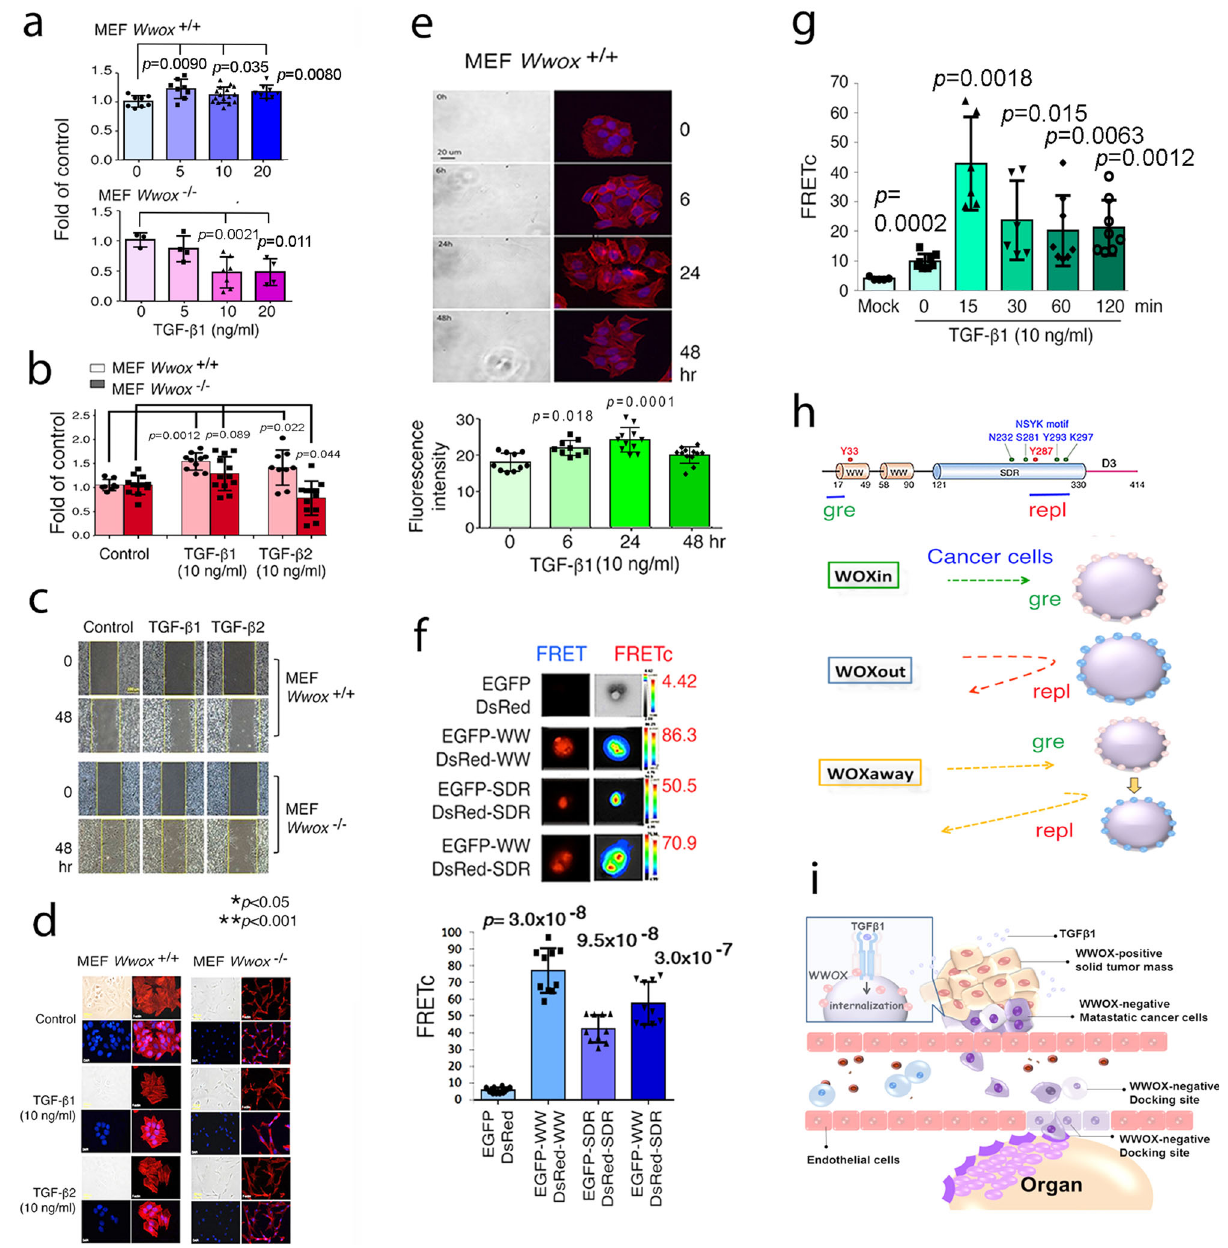
Fig. 10 TGF- β 1-enhancement of the migration of wild type MEF cell migration is associated with stress fi ber formation and modulates WWOX self- binding or intermolecular association. a Wwox + / + and Wwox -/- MEF cells were treated with TGF- β 1 for 48 hrs. The extent of cell migration was measured. TGF- β 1 promoted wild type cell migration and suppressed the knockout cell migration in a dose-dependent manner. b , c Under similar conditions, TGF- β 1 and TGF- β 2 promoted the wild type cell migration. TGF- β 2 suppressed knockout cell migration. d MEF cells were treated with TGF- β 1 or TGF- β 2 for 48 h. In wild type cells, TGF- β 1/- β 2 induced stress fi ber formation as the F-actin appeared as bundles in cytoplasm. However, in the knockout cells, the arrangement of F-actin showed no apparent differences between control and TGF- β stimulated cells. e In wild type MEF cells, TGF- β 1 stimulated stress fi bers formation in a time-dependent manner. F-actin (red) was stained by phalloidin. DAPI (blue) stain reveals the nuclei (mean ± s.d., n = 10, student ’ s t test). f COS7 fi broblasts were co-transfected with a pair of expression constructs: (1) EGFP and DsRed, (2) EGFP-WW ( N -terminal 1st and 2nd WW domains) and DsRed-WW; (3) EGFP-SDR and DsRed-SDR; (4) EGFP-WW and DsRed-SDR. FRET analysis was carried out. The extent of speci fi c protein/protein interactions is calculated as FRETc. g TGF- β 1 (10 ng/ml) increased the binding between WW and SDR domain in 15 min, followed by gradual decrease with time (mean ± standard deviation; n = 30; Student ’ s t test). h The potential modes of cell migration are: (1) WOXin: WWOXd cells look for WWOXd or gre-exposed WWOXf cells in the lymphatic capillaries or organs for docking and invasion; (2) WOXout: WWOXd cells turn away from repl-exposed WWOXf cells; (3) WOXaway: WWOXd cells physically contact and merge with gre-expressing cells, but walk away upon gre turning to repl. i Cancer cell-derived TGF- β 1 induces internalization of WWOX and T β RII that facilitate the cell migration. WWOXf parental cells in the solid tumor can no longer recognize the WWOXd cells and repel them to depart. These metastatic cells look for WWOXd or gre-exposed WWOXf cells in the blood or lymphatic capillaries as docking sites, so as to penetrate, dock and grow in target organs. TGF β or probably other cytokines participate in WWOX-mediated cell migration and cell-to-cell